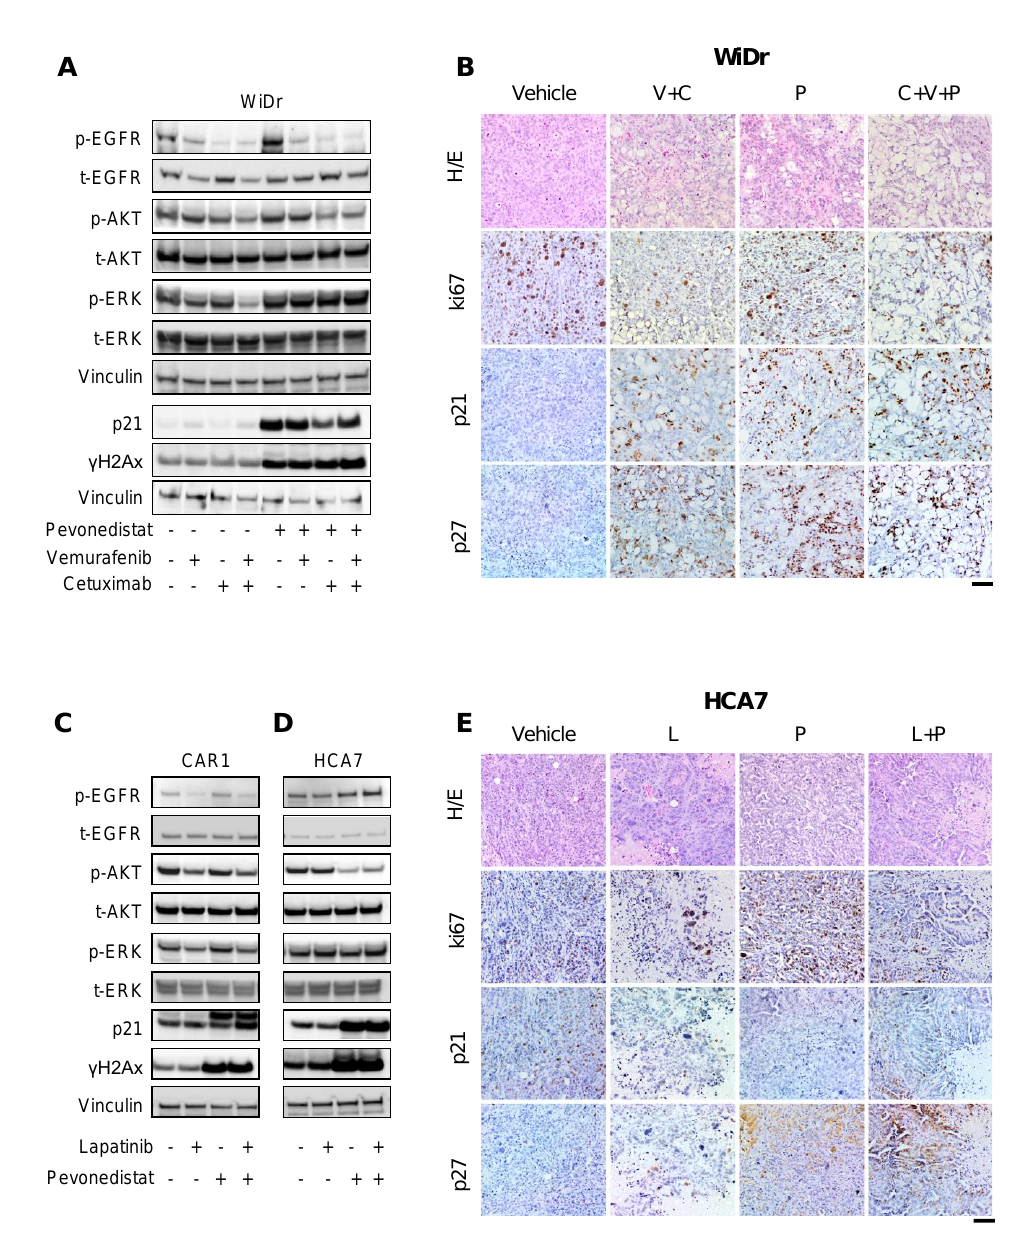
Figure 5. Characterization of BRAF -mutant and RAS/RAF WT CRC response to pevonedistat and EGFR inhibition . ( A ) Western blot was performed on lysates from WiDr cells treated with pevonedistat (1 µM), cetuximab (20 µg/mL), vemurafenib (1 µM), or their combinations for 24 h. EGFR, AKT, and ERK in their phosphorylated (p-) or total (t-) forms were evaluated. P21 and γ H2Ax were analyzed in the aforementioned conditions. Vinculin was used as a normalizer. The uncropped Western blots have been shown in Figure S5. ( B ) Tumors from WiDr cells were treated with vehicle, pevonedistat (90 mg/kg), cetuximab (20 mg/kg), and vemurafenib (60 mg/kg) alone or in combination. Tumor sections after drug treatments (V: vemurafenib; C: cetuximab; P: pevonedistat) were analyzed by EE and IHC for proliferative marker (ki67, p21, and p27). Representative images were acquired at 10 × magnification. Scale bar: 200 µ m. ( C , D ) Western blot was performed on lysates obtained from drug-treated RAS/RAF WT CRC cells CAR1 ( C ) and HCA7 ( D ). CAR1 were treated with pevonedistat (0.5 µ M), lapatinib (0.25 µ M), or their combinations at 24 h after drugs treatment ( C ). HCA7 were analyzed upon 48 h treatment with pevonedistat (1 µ M), lapatinib (1 µ M), or their combinations ( D ). EGFR, AKT, and ERK in their phosphorylated (p-) or total (t-) forms were evaluated. p21 and γ H2Ax protein levels were evaluated in the aforementioned conditions. Vinculin was used as a normalizer. ( E ) HCA7 transplanted mice were treated with pevonedistat (90 mg/kg) and lapatinib (100 mg/kg) or their combination. Tumor sections after drug treatments (L—lapatinib; P—pevonedistat) were processed and analyzed as described in panel ( B